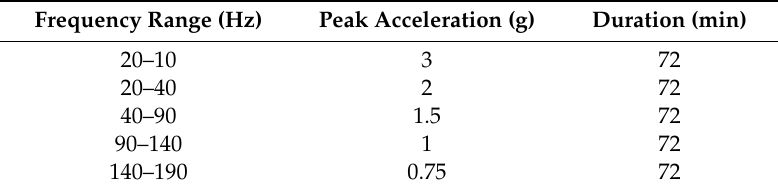
Table 1. Test profile for sinusoidal vibration.